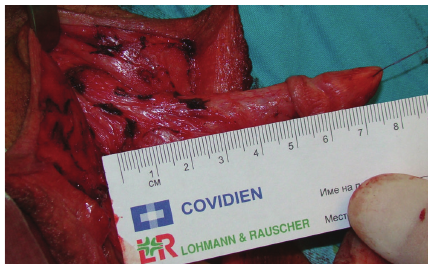
Figure 3: Corpora with glans are 8 cm in length after complete di- visionofclitoralligamentsdorsallyandshorturethralplateventrally.